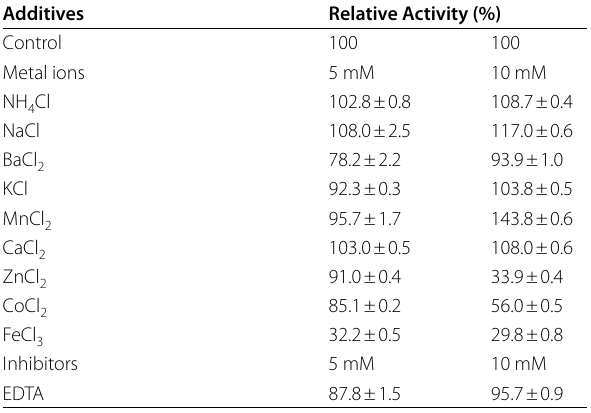
Table 1 Effects of metal ions and EDTA on the enzyme activity